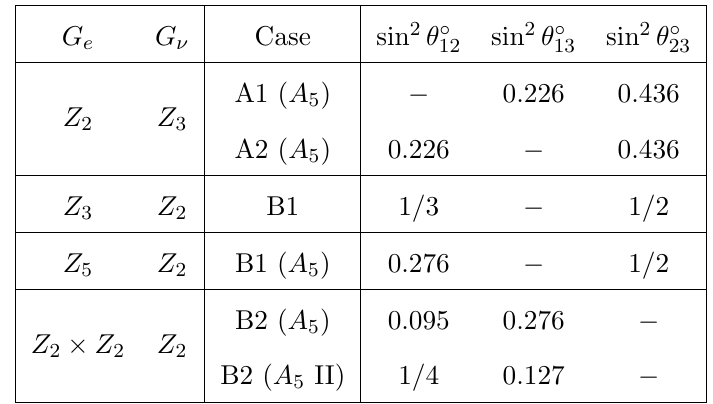
for viable cases originating from G f = A 5 broken ij